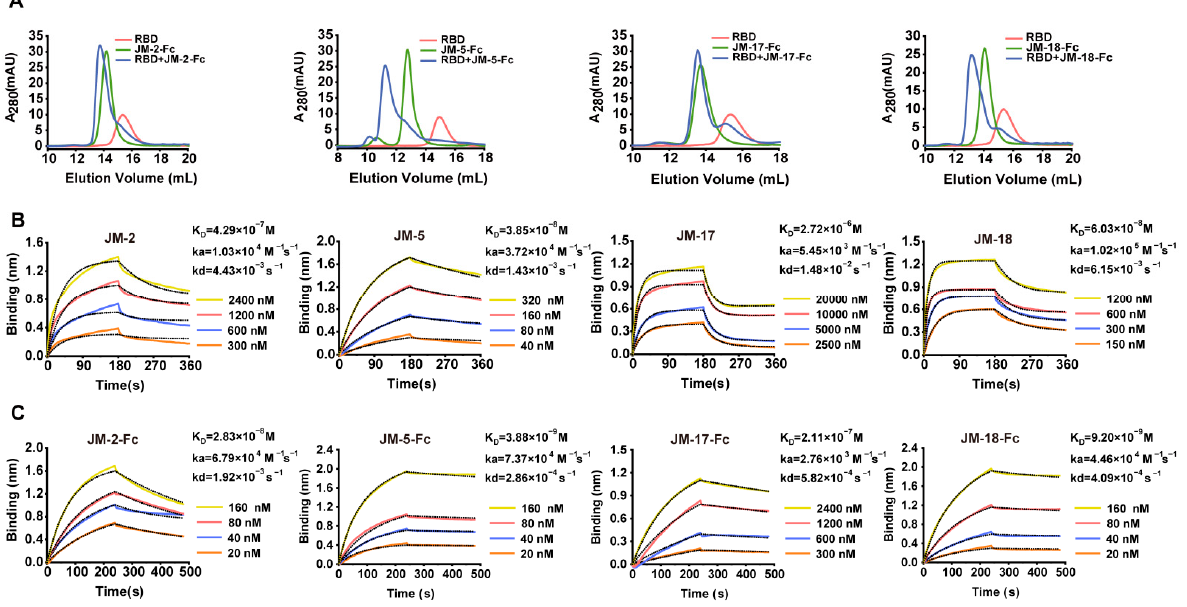
Figure 2. Characterization of the interaction between VNAR fusions and RBD. ( A ) RBD, VNAR-Fc fusions, and their molar mixture (1:1) loaded over a Superdex 200 column. The elution peak from the mixtures appeared earlier than those from RBD and VNAR-Fc fusions. ( B , C ) Characterization of binding affinity of isolated VNARs ( B ) or VNAR-Fc fusions ( C ) for RBD using BLI. The actual responses (colored lines) and the data fitted to a 1:1 binding model (black dotted lines) are shown. ka and kd represent the association and dissociation constants, respectively. The equilibrium dissociation constant K D was calculated as kd/ka. Table 1. K D , ka, and kd values of VNARs, VNAR-Fc fusions, bi-paratopic VNARs, and bi-paratopic